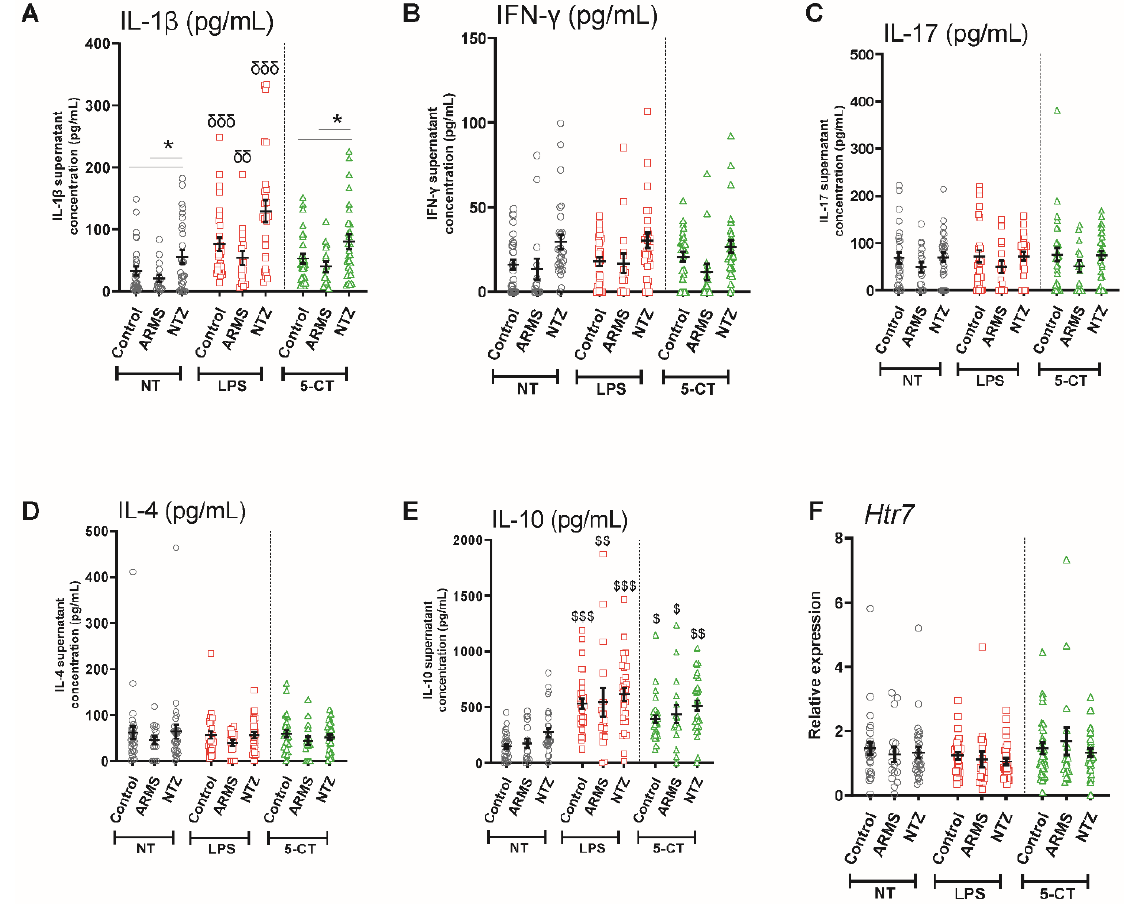
Figure 4. Effects of 5-HT 7 receptor agonist 5-CT on PBMC cytokine releases compared to LPS stimulation. Cytokines assays: IL- 1β ( A ), IFN- γ ( B ), IL-17 ( C ), IL-4 ( D ), and IL-10 ( E ) were performed from PBMC supernatants of control, ARMS, and NTZ patients. Htr7 was analyzed by RT-qPCR. The relative expression of Htr7 mRNA levels, normalized to Gapdh and Hprt1 of non-treated PBMCs from the control, is shown ( F ). Results are given as mean ± SEM. *: compare the values under the bars. $: compare with the respective non-treated (NT) condition. Compare with both NT and 5-CT conditions. * p < 0.05; $ p < 0.05; $$ p < 0.01; $$$ p < 0.001; δδ p < 0.01; δδδ p < 0.001.